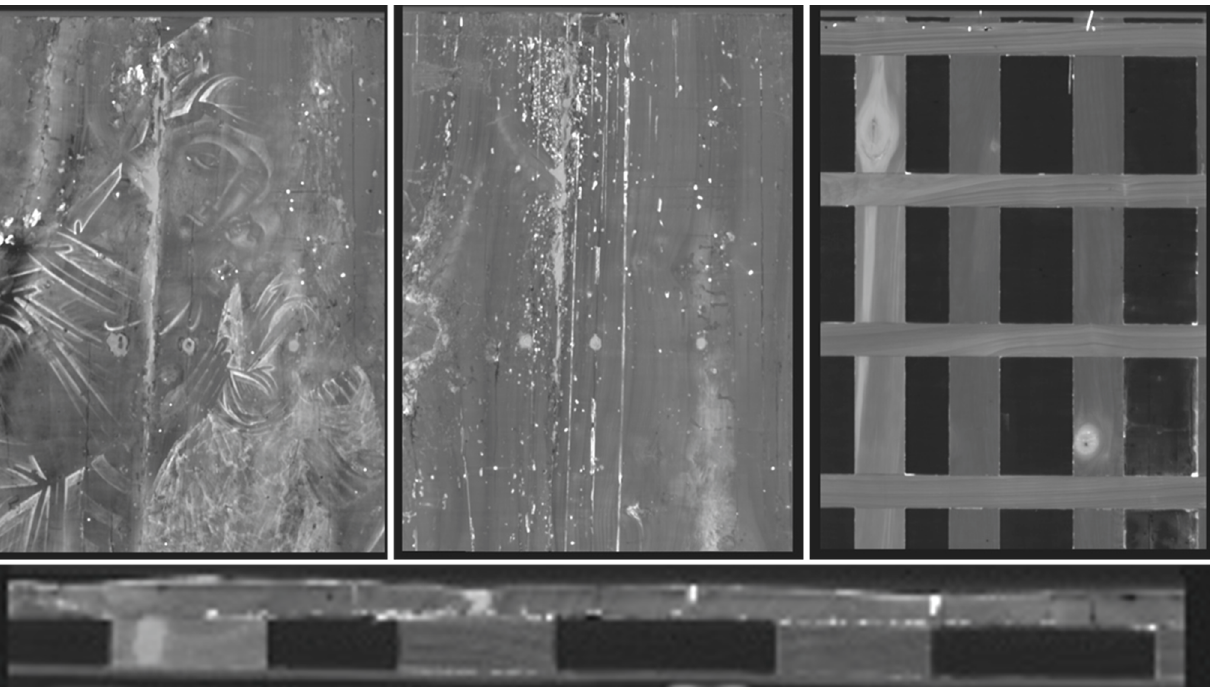
Figure 5. CT scan. ( Top from left to right ) front of the Icon, towards the Icon, the parking area; ( down ) the lower and upper section.